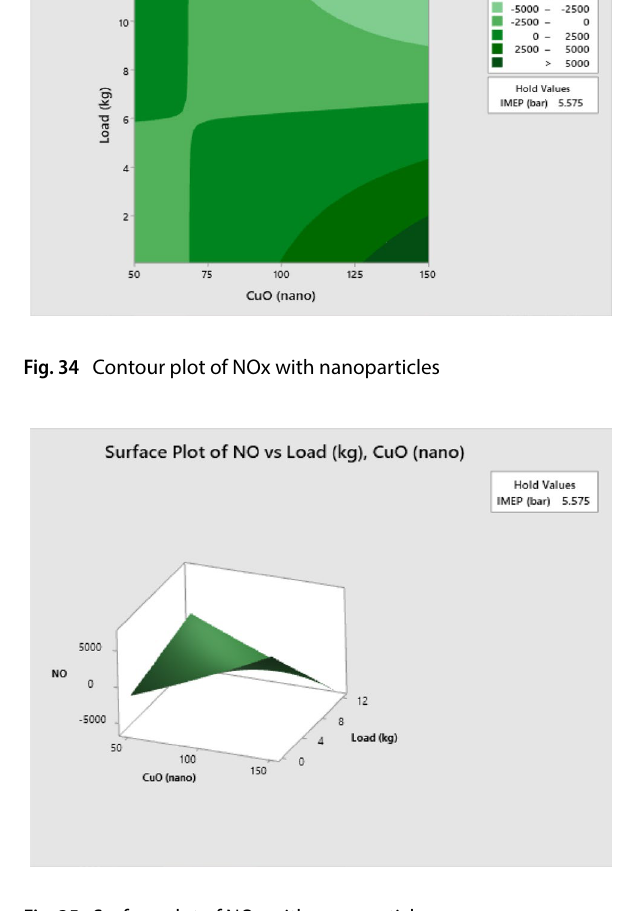
Fig. 35 Surface plot of NOx with